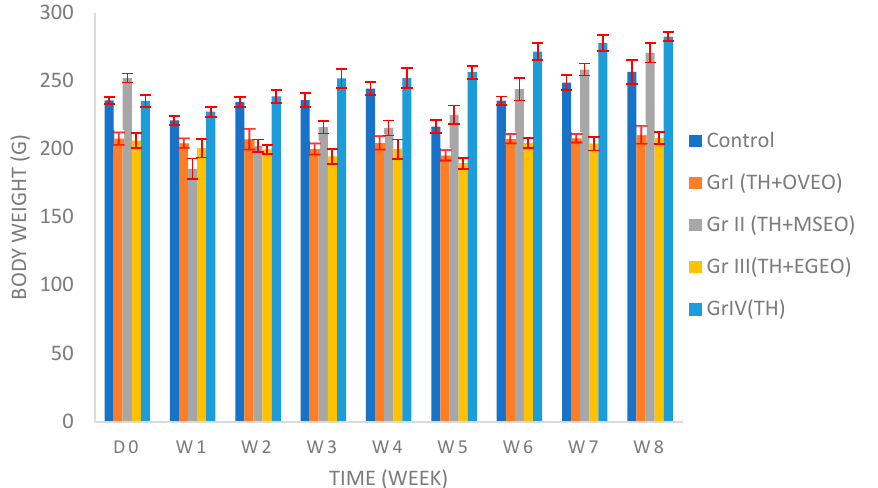
Figure 3. Representative graphs for body weight changes for rats treated with Thyme honey and mixtures of honey with essential oils. TH: thyme honey, OVEO: O. vulgare essential oil, MSEO: M. spicata essential oil, EGEO: E. globulus essential oils.